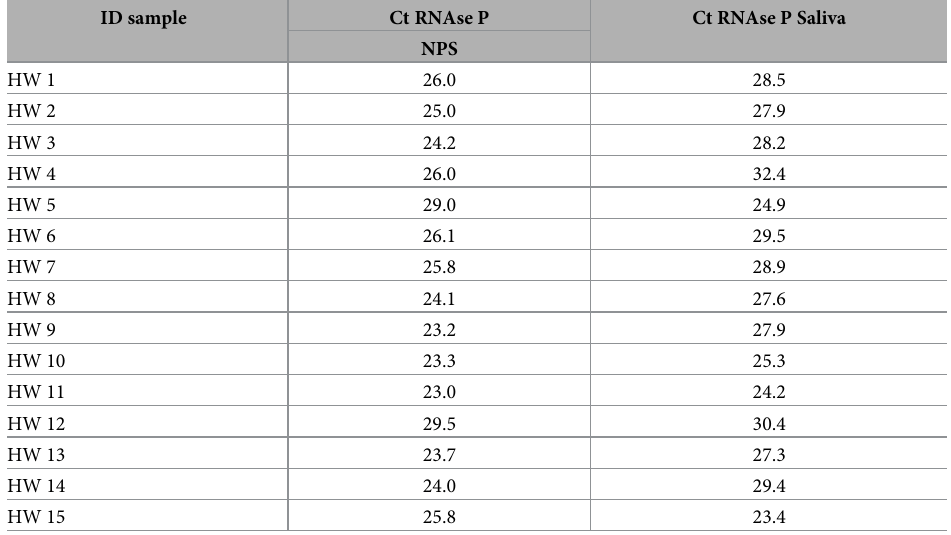
Table 2. Comparison of RNAse P in paired samples (NPS and saliva) of healthcare workers (HW). ID sample Ct RNAse P Ct RNAse P